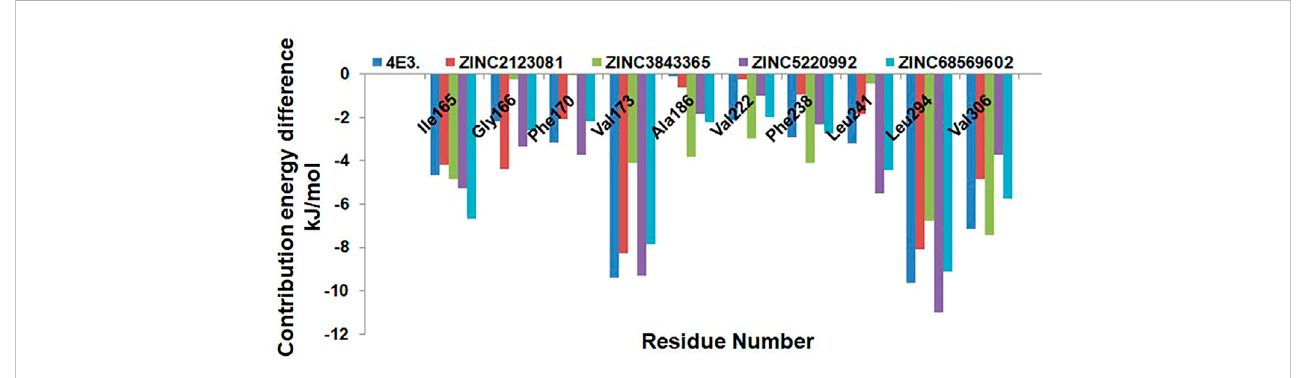
FIGURE 9 Residue-wise decomposition of the binding free energy. Only the catalytic residues which are actively participating in the ligand stabilization are plotted here.